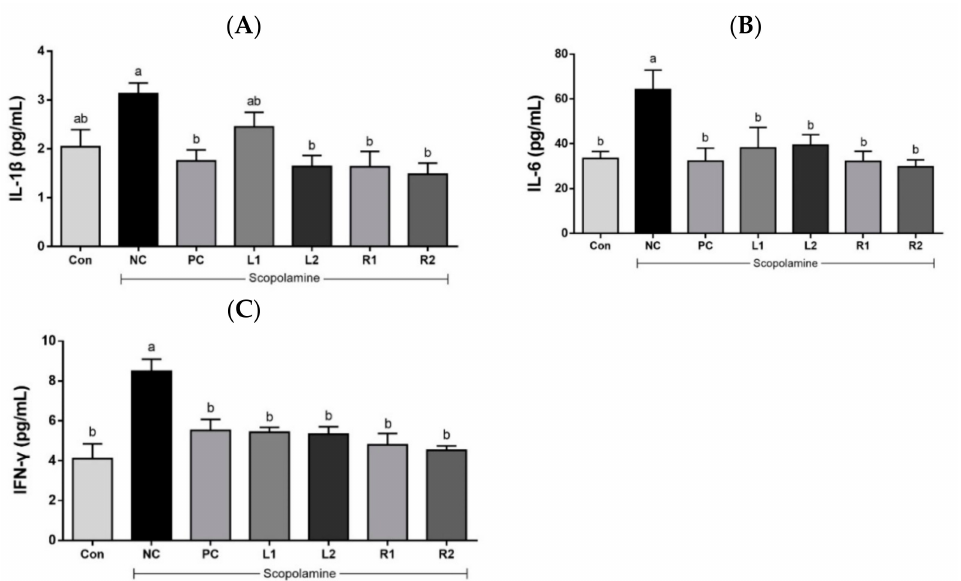
Figure 5. Effects of AH leaf and root extracts on serum inflammatory cytokines ( A ) IL-1 β , ( B ) IL-6, and ( C ) IFN- γ levels of C57BL/6 mice with scopolamine-induced memory impairment. All values are expressed as the mean ± SEM ( n = 7). a,b Differences were considered statistically significant at p <